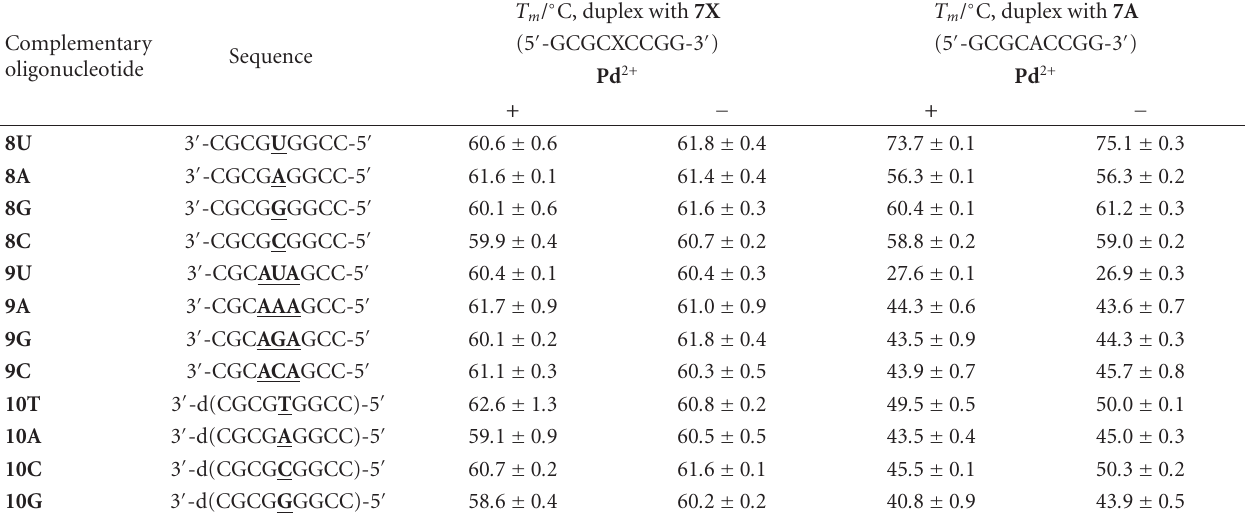
Table 2: The T m of the duplexes formed between modified (7X) or unmodified (7A) oligonucleotide and complementary 2 (cid:2) - O -methyl- RNA (or DNA) sequences bearing A, G, U (or T), or C nucleoside opposite to the artificial nucleoside 1 (in the case of oligonucleotide 7X ) or adenosine (in the case of oligonucleotide 7A ) in the presence and absence of Pd 2+ ; [oligonucleotides] = 3.0 μ M, [K 2 PdCl 4 ] = 0/3.0 μ M, I (NaClO 4 ) = 0.1 M; pH =